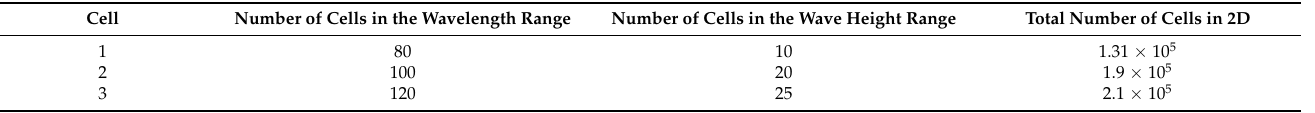
( b ) Wave probe 2 Figure 3. Comparison of the wave elevation of different cells. 3.1.3. Time Step Convergence Analysis The time step also has a great impact on the calculation accuracy, so it is necessary to verify the convergence of the time step. Based on the grid convergence verification, cell 2 is selected in this section for time step convergence verification. In this paper, the time step is set to 0.0015 s, 0.002 s, and 0.0025 s, and other settings remain unchanged. Wave duration curves under different time steps are obtained, as shown in Figure 4.